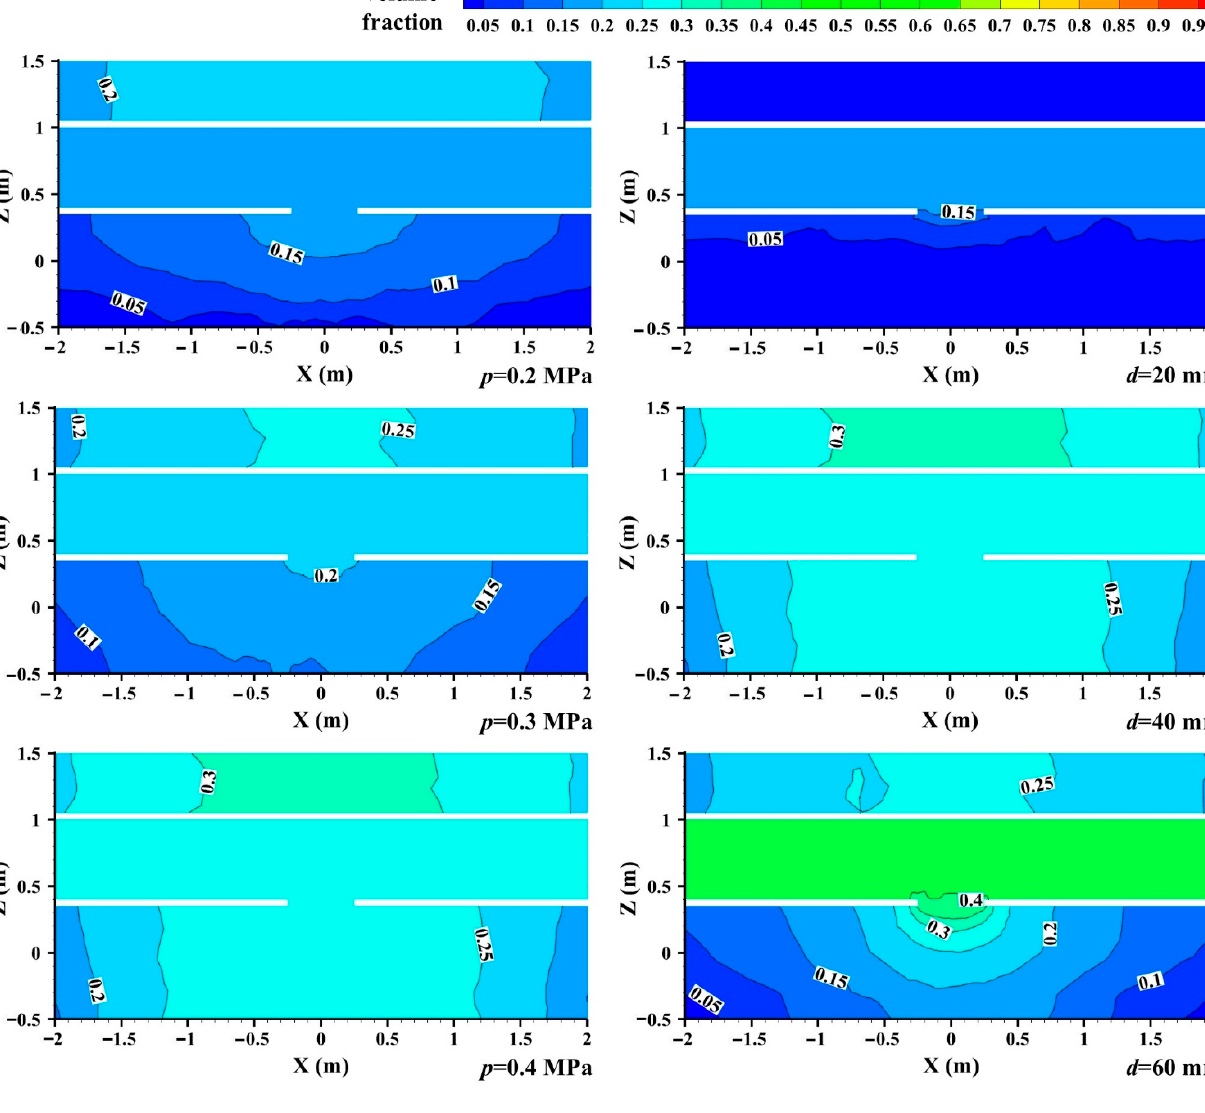
Figure 14. The influence of pipeline operating pressure and leakage diameter on gas concentration distribution in confined space.